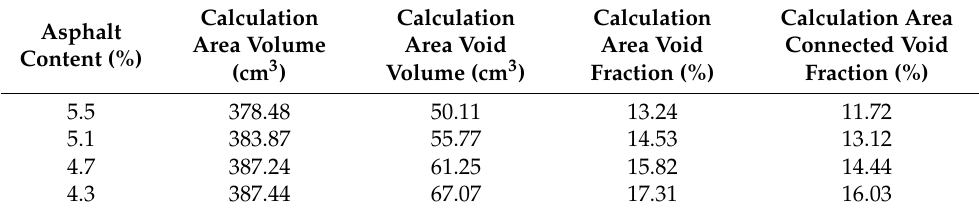
Figure 4. EPA-13 scanning calculation area. Table 4. Characteristic parameters of EPA-13 CT scanning void.